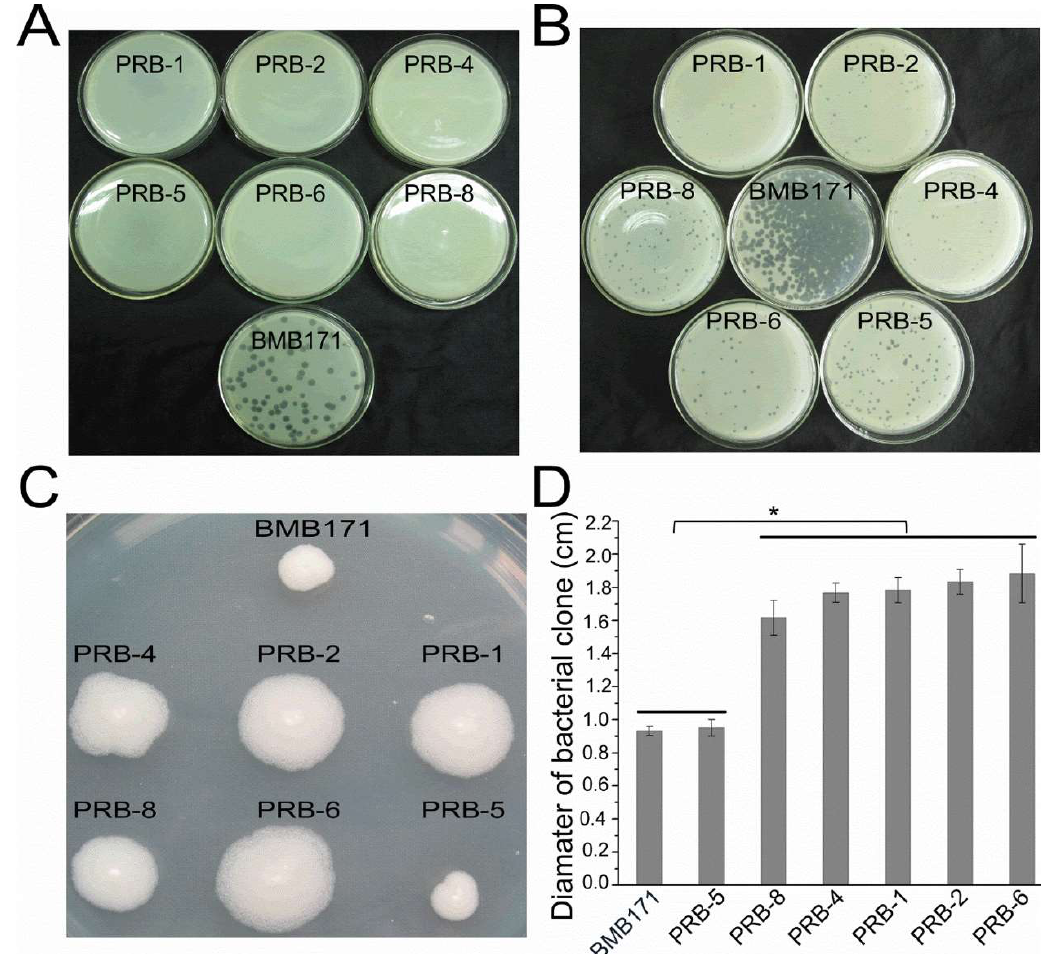
Figure 1. Isolation and characterization of phage-resistant mutants of BMB171 and regained-infectivity phage mutants of vB_BthS_BMBphi. ( A ) Phage-resistant mutants of BMB171 isolated in this study. ( B ) Infectivity of regained-infectivity phage mutants vB_BthS_BMBphi-M1 to the phage-resistant strains and BMB171. ( C ) The mobility of the strains BMB171 and the phage-resistant mutants. The agar plate with a concentration of 0.3% was used for bacterial mobility analysis. ( D ) Comparison of the bacterial clone size of strain BMB171 and the phage-resistant mutants. For each strain, 30 clones were used for the analysis of the clone diameters, and the asterisk indicates a significant difference ( p < 0.05) between the diameter of different bacterial clones.